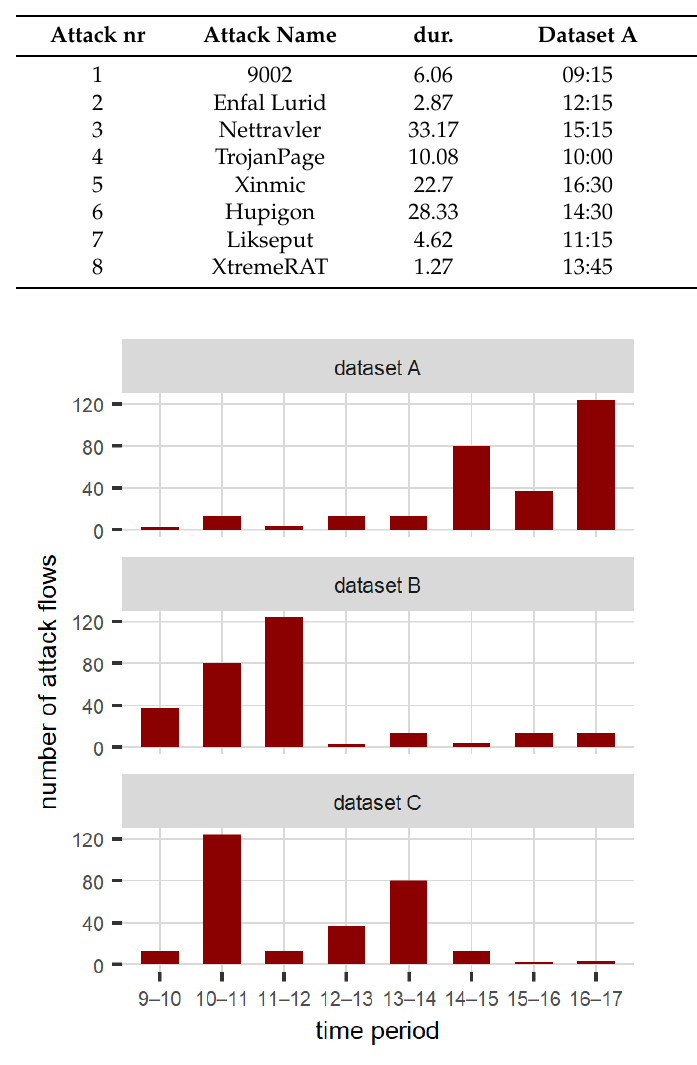
Table 2. Dataset, including the time of each attack.